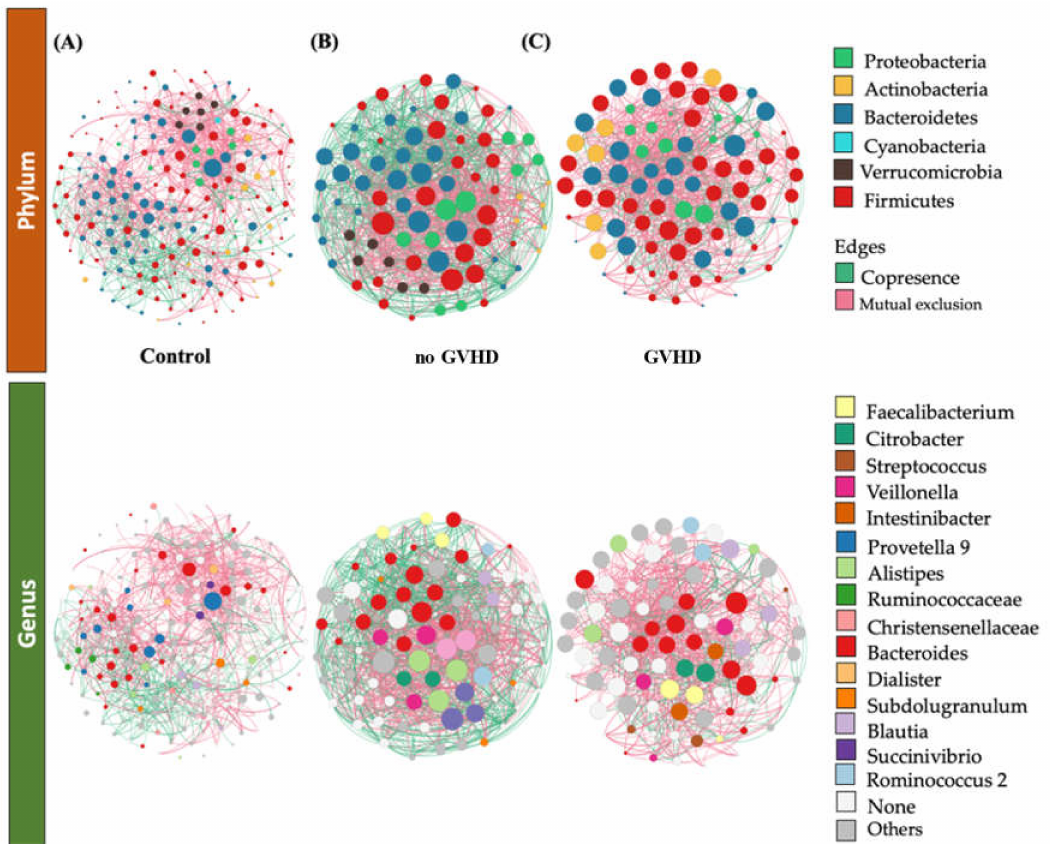
Figure 4. Significant co-occurrence (red edges) and mutual exclusion (green edges) network analysis. Interactions among OTUs in ( A ) control group ( n = 18), ( B ) GvHD patient group ( n = 4) and in ( C ) the no GVHD subgroup ( n = 11). For each group, the nodes correspond to the present OTUs colored according to phylum or genus affiliation. The size of the nodes is proportional to their degree of connection (the number of edges associated with the